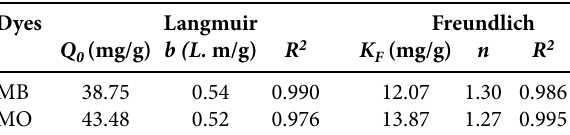
Table 1. Isotherm parameters of MB and MO onto GCM at 25 °C (n = 3, the reported values are mean of three measurements). Dyes Langmuir